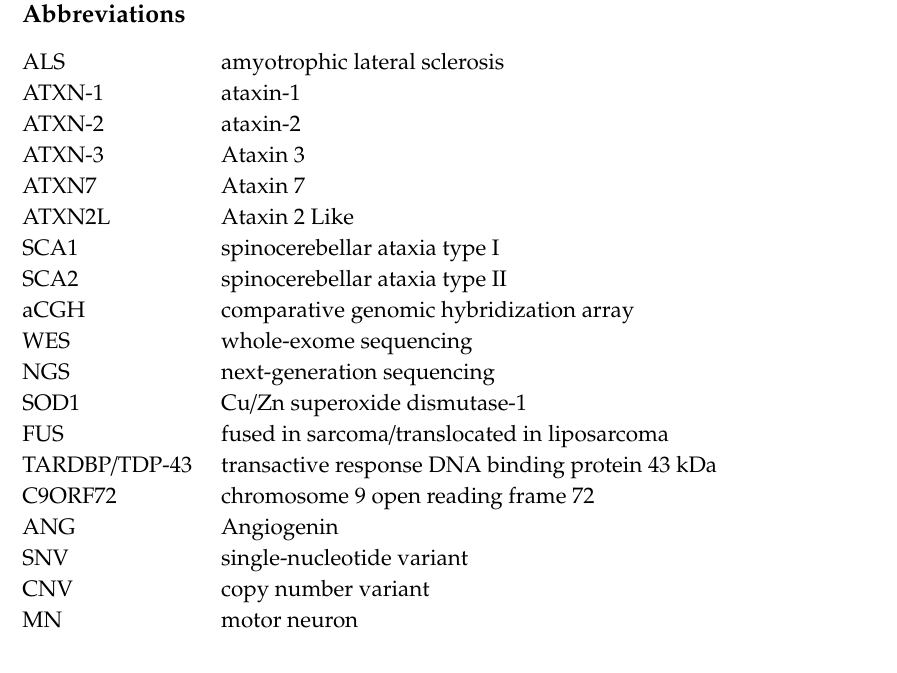
Figure S1. PPI network including genes a ff ected by rare non-coding and / or potentially pathogenic coding variants identified in the ALS patient. The node size was proportional to the degree and the edge width was proportional to the combined score based on the STRING database. Genes with higher degree values have a stronger capacity of modulating adjacent genes. Table S1. Results of customized targeted ALS NGS panel in the ALS patient. Table S2. CNVs identified in the SCA1-MN patient IV-18 by NeuroArray aCGH. Table S3. CNVs identified in the SCA1-MN aCGH. Table S5. Functional enrichment analyses of the CNV-associated gene sets in ALS and SCA1-MN family members. Table S6. Results of whole-exome sequencing in the ALS proband. Table S7. Functional enrichment analyses of the CNV-associated gene sets in ALS and SCA1-MN family members. Table S8. Protein–protein interaction network